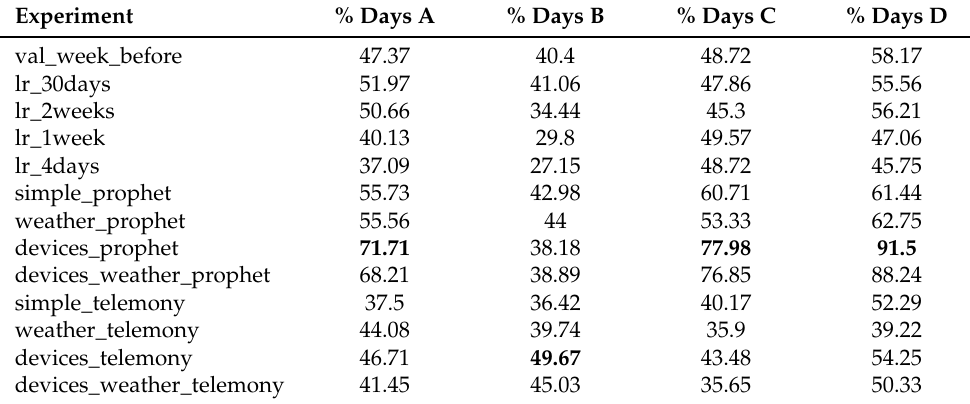
Table 3. The percentage of days for which an error of less than 25% was obtained, determined for each location and each experiment. The results that obtained the highest value for each location are marked in bold.